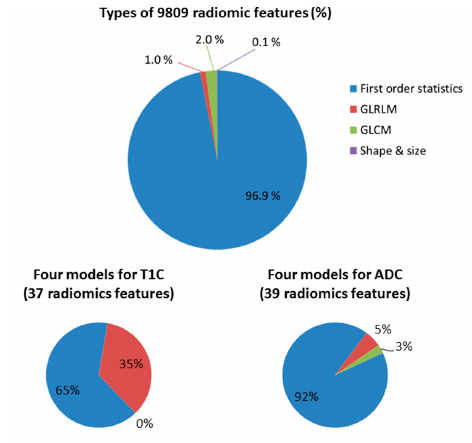
Figure 6. Proportions of feature classes before and after filtering. Four classes of radiomic features, including first-order statistics, gray-level run length matrix (GLRLM), gray-level co-occurrence matrix (GLCM), and shape and size, were used in this study. The top figure indicates the proportions of each class before feature filtering. The bottom left figure indicates the percentages of feature classes used for models trained using T1C magnetic resonance (MR) imaging data. Similarly, the bottom right figure indicates the percentages of feature classes used for models trained using ADC MR imaging data. Cancers 2020 , 12 , x Table 3. Summary of distinct radiomic features for models derived from T1C and ADC.